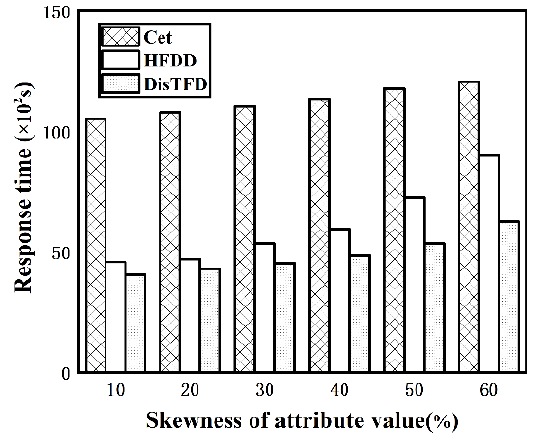
Figure 10. Evaluation of effectiveness of load balancing.